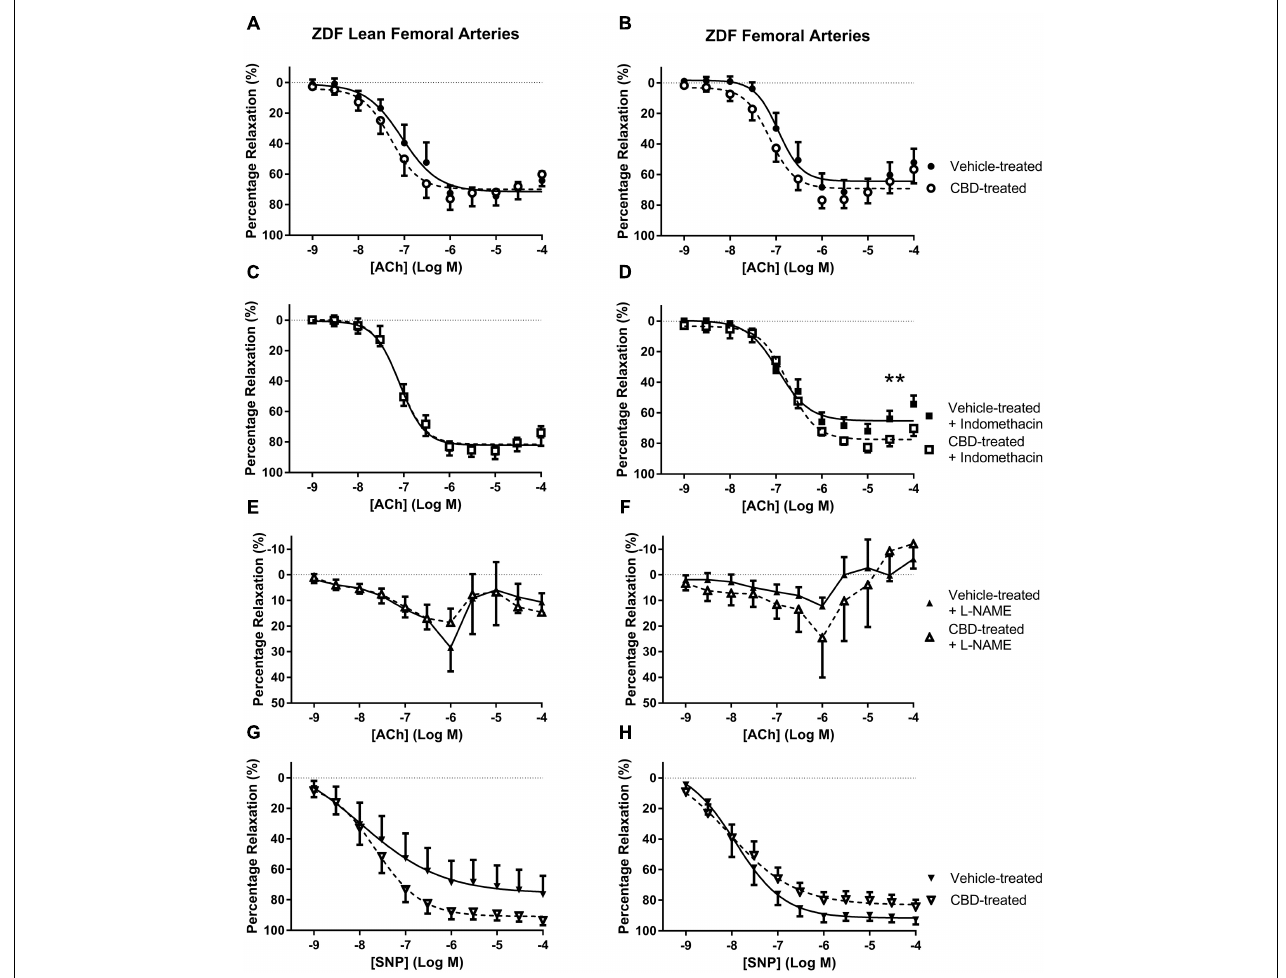
FIGURE 3 | The effect of CBD (open symbols) or vehicle (closed symbols) treatment on ex vivo responses to ACh (A–F) and SNP (G,H) in rings of femoral arteries taken from ZDF Lean (left side) or ZDF rats (right side). Some arteries were incubated in vitro in the presence of 3 µ M indomethacin (squares, C,D ), or 300 µ M L-NAME (upward triangles, E,F ). Data are mean ± SEM, n = 5/6. ∗∗ P < 0.01 comparing the efficacy ( R max ) of Ach in ZDF arteries after 7 days CBD